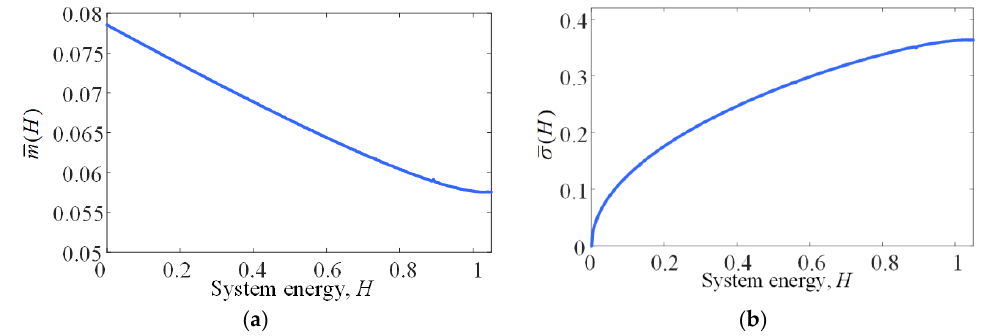
Figure 3. The coefficients of the equivalent Itō stochastic differential equation for the system energy: ( a ) the drift coefficient m ( H ); ( b ) the diffusion coefficient σ ( H ).